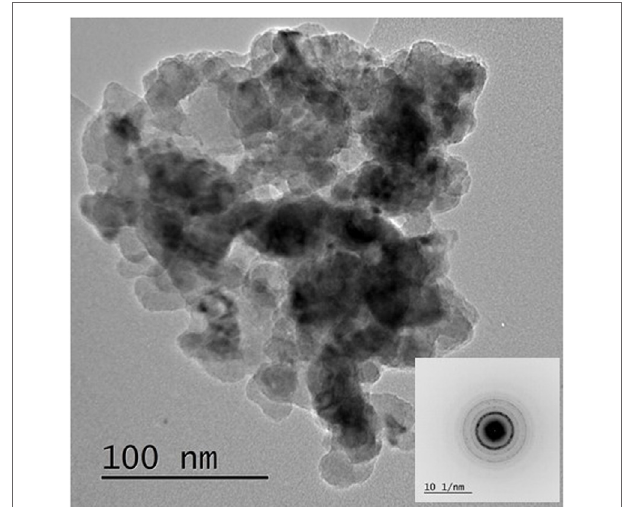
FigUre 7 | Comparison of the Cu particles sizes and dielectric constants in the different solvents after low-temperature methanol synthesis reaction.